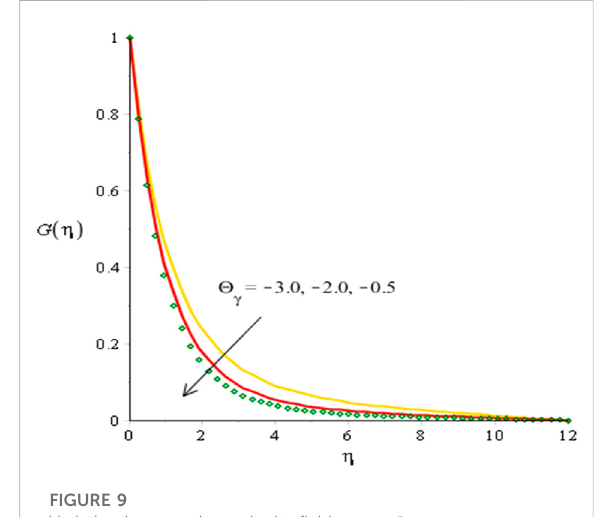
FIGURE 7 Variation in secondary velocity fi led versus β e .